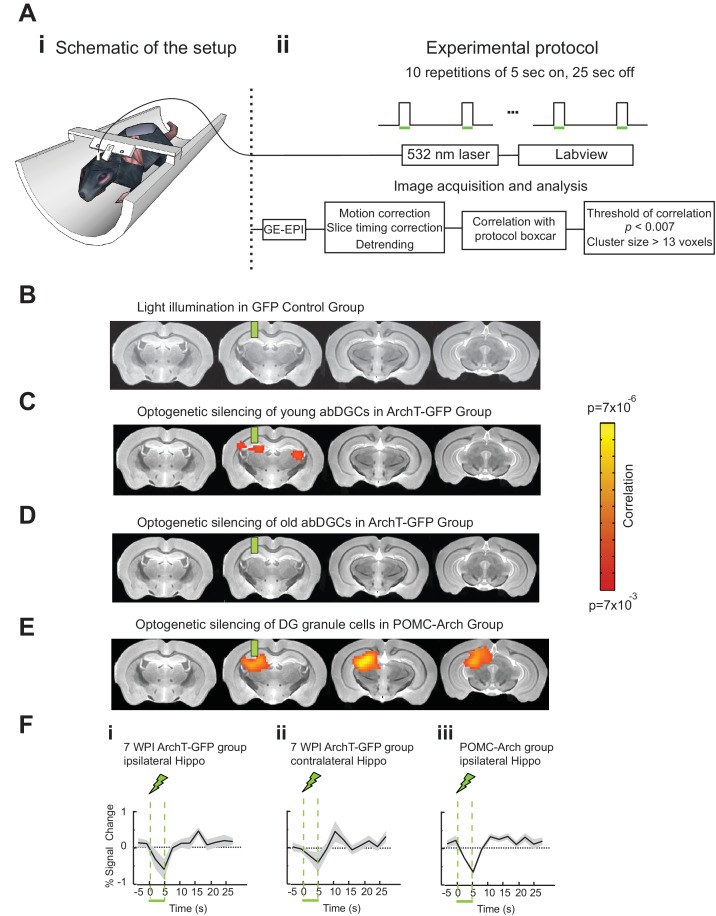
AbDGCs effectively modulated BOLD signals in bilateral hippocampus at seven week maturation.(A) Opto-fMRI experimental set-up (i) and imaging protocol (ii). (B) No voxels showed changes upon light illumination in the right DG, in GFP-control mice (n = 7 mice). (C) Voxels showed significant BOLD signal changes upon optogenetic silencing of young abDGCs (seven week maturation) in the right DG (n = 8 mice). BOLD signals were aligned to the standard mouse atlas. Color indicates the correlation P value for each voxel. (D) No voxels showed changes upon optogenetic silencing of older abDGCs (16 week maturation, n = 8 mice, same animals as in C). (E) A lager area is affected by optogenetic silencing of the DG in POMC-Arch transgenic mice, including both developmental-born and adult-born DGCs (n = 5 mice). (F) Time courses extracted from the affected voxels of (i) ipsilateral and (ii) contralateral hippocampus of ArchT-GFP group at 7wpi, and (iii) ipsilateral hippocampus of the POMC-Arch group. Green bars indicate the locations of implanted optical fibers.